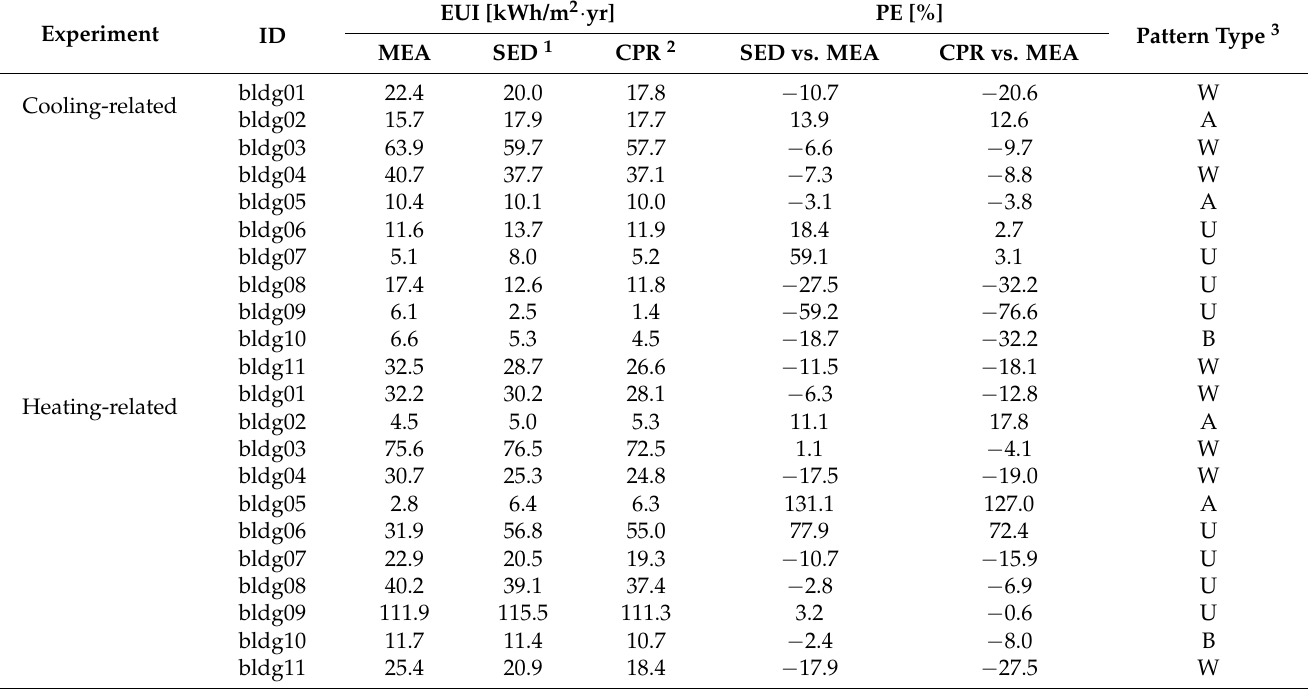
Table 5. Individual comparison among three